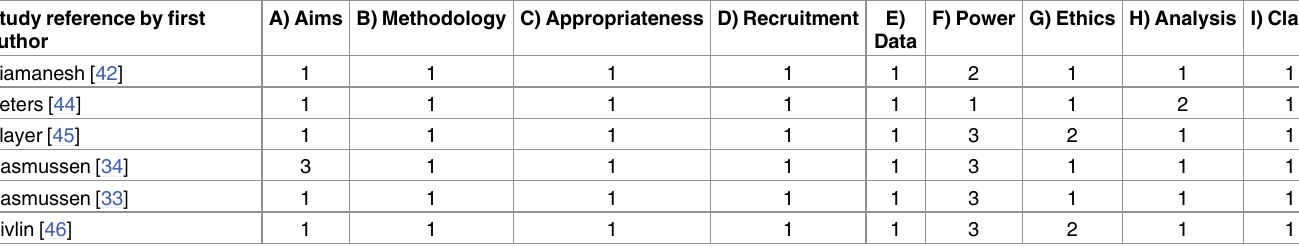
Table 4. Qualitative quality assessmentled by the CASP assessment. Study reference by first